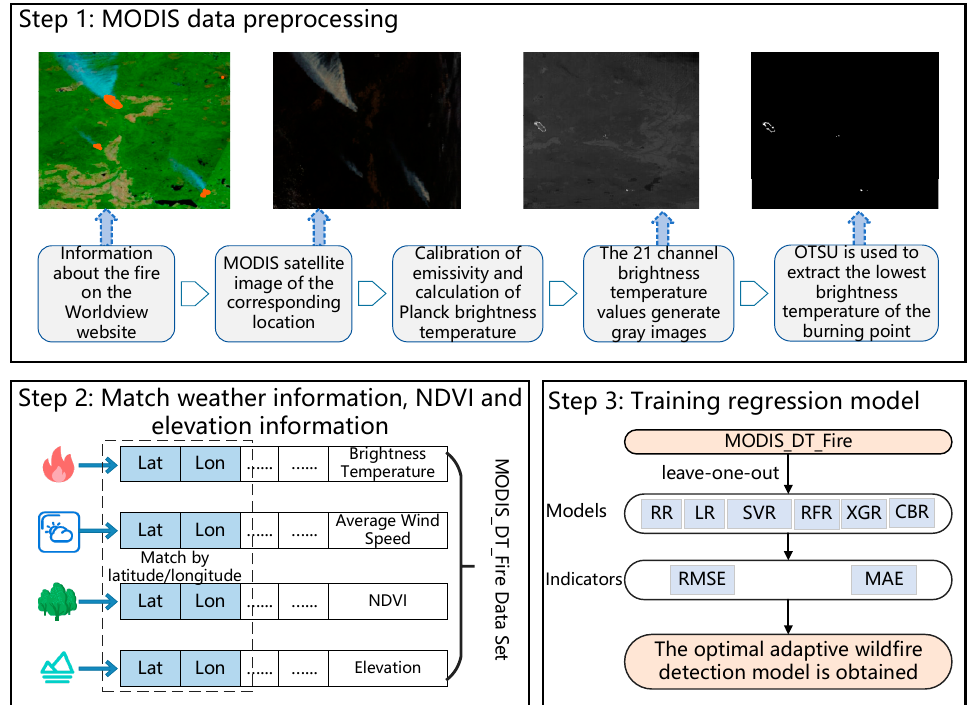
Figure 1. Overall flowchart of adaptive wildfire detection algorithm for dynamic brightness tem ‐ perature threshold. Step 1 is the extraction process of the minimum brightness temperature of ignition point combustion; Step 2 is the extraction and matching process of meteorological, NDVI, altitude, and other features; Step 3 is the process of regression evaluation of the dataset generated in Step 2. Lat: latitude; Lon: longitude; NDVI: normalized differential vegetation index; RR: ridge regression; LR: least absolute shrinkage and selection operator regression; SVR: support